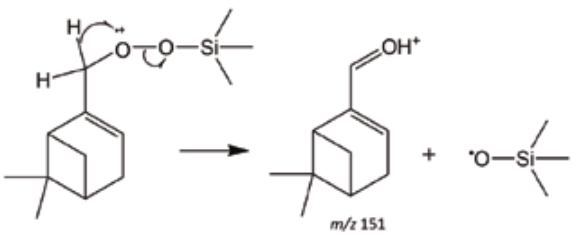
Figure 6. The mechanism for the formation of the fragment m/z 151, which is formed in higher amount in myrtenyl-hydroperoxide